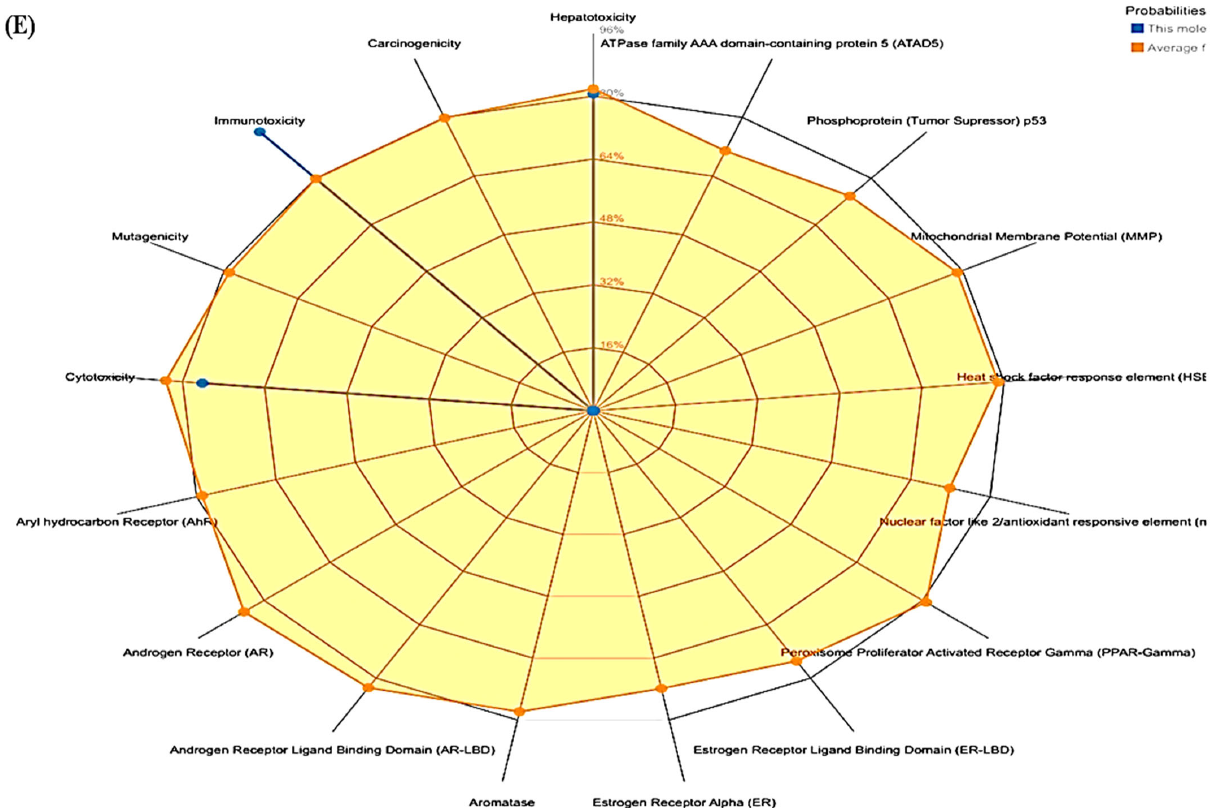
Figure 3. Radar chart of toxicities of phytocompounds and drug by ProTox ‐ II. Table 4. Toxicity analysis of natural compounds and drug.